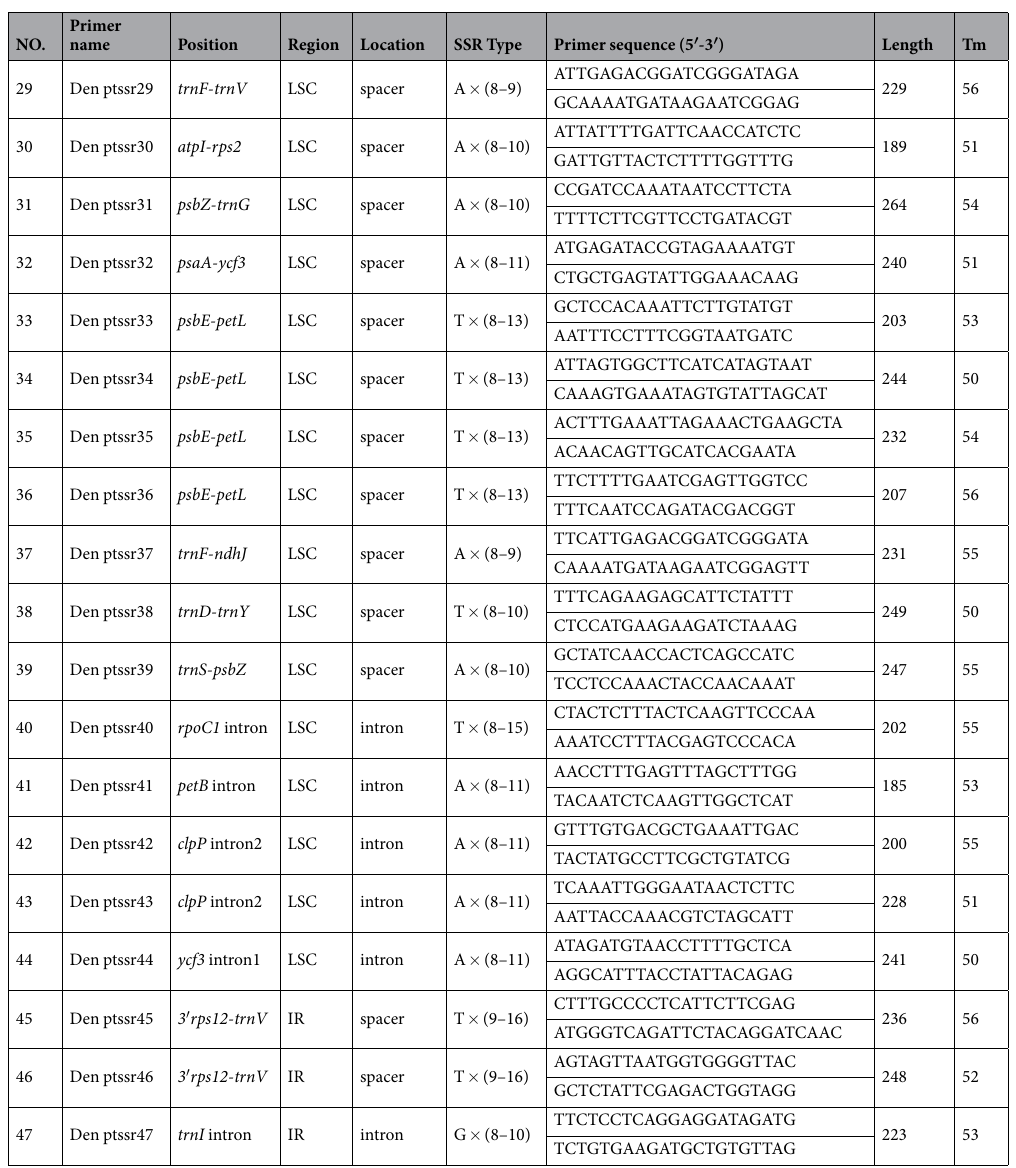
Table 3. Polymorphic SSRs identified in the comparative analysis of Dendrobium